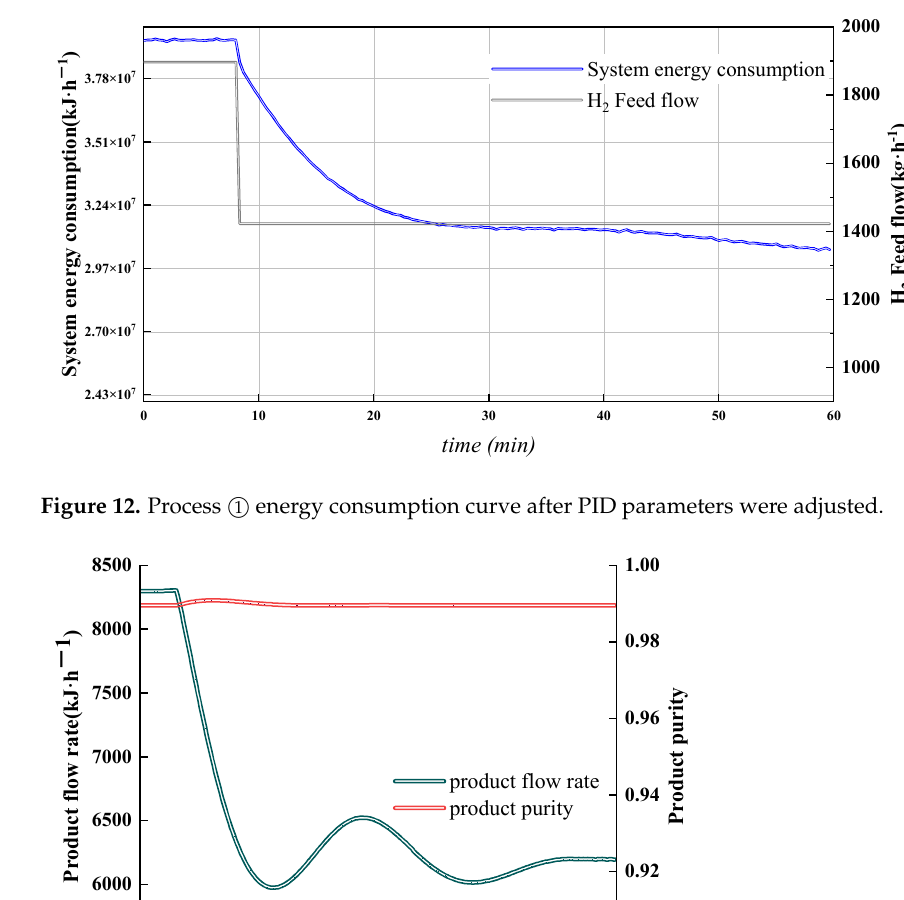
Figure 13. Process ① product curve after PID parameters were adjusted.